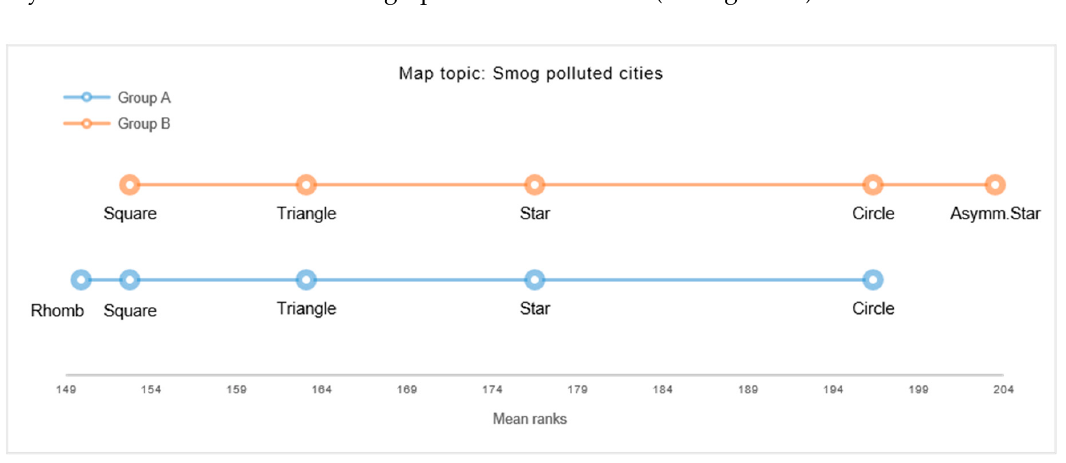
Figure 16. Map #12: Results of multiple pairwise comparisons, indicating two groups of symbol-content congruence, yet, of insignificant statistical differences.